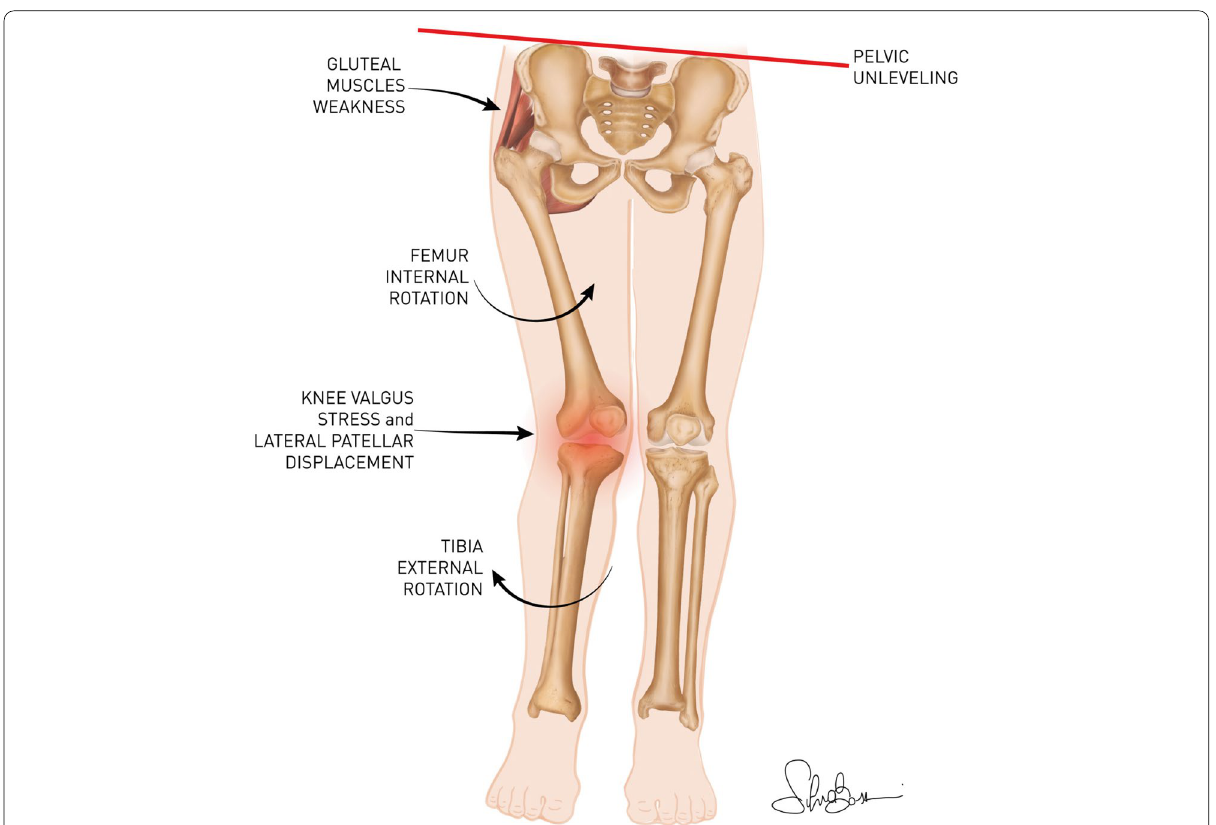
Fig. 2 Gluteal Muscles weakness leads to adduction and internal rotation of the femur, valgus at the knee, and tibia external rotation